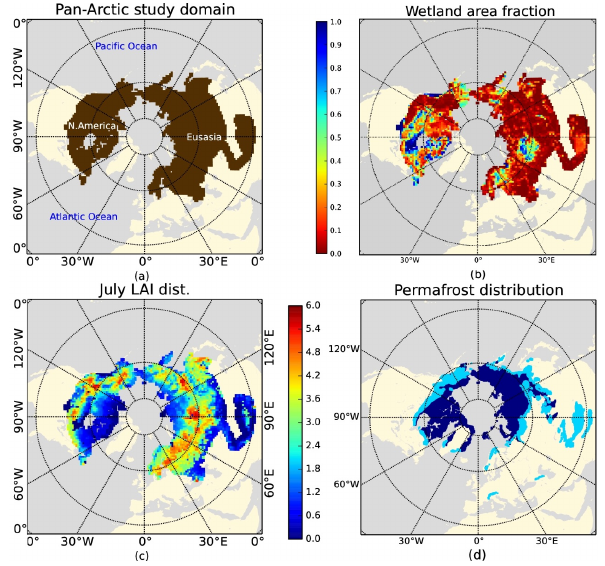
Figure 1. Relevant characteristics of study domain: (a) spatial ex- tent of the domain; (b) lake or wetland area fractions (taken from Lehner and Döll, 2004, and Tarnocai et al., 2009; see text for de- tails); (c) July LAI (taken from Myneni et al., 2002); (d) permafrost distribution (taken from Brown et al.,